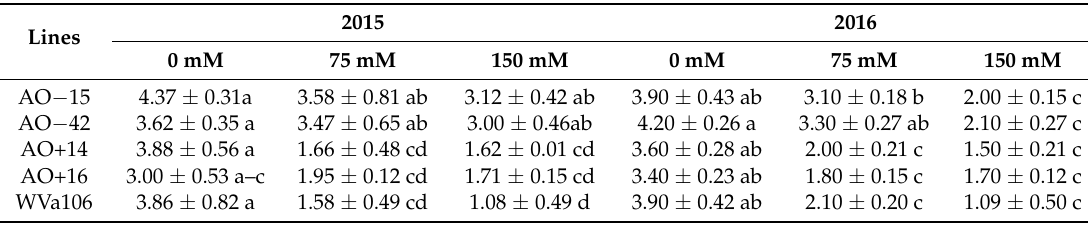
Table 3. Carotenoid content ( µ g g − 1 FW) of lines with low or elevated AO activity and non-transgenic line of red-ripe cherry tomato fruits under two salinity levels (75 and 150 mM NaCl) in 2015 and 2016. Results with the same letter were not significantly different ( p < 0.05) according to the classification obtained by the Duncan